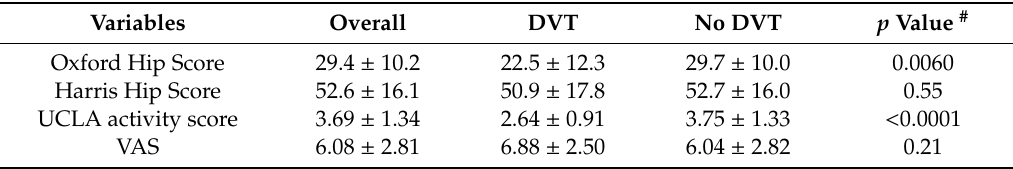
Table 3. Clinical measurement scores for each group.